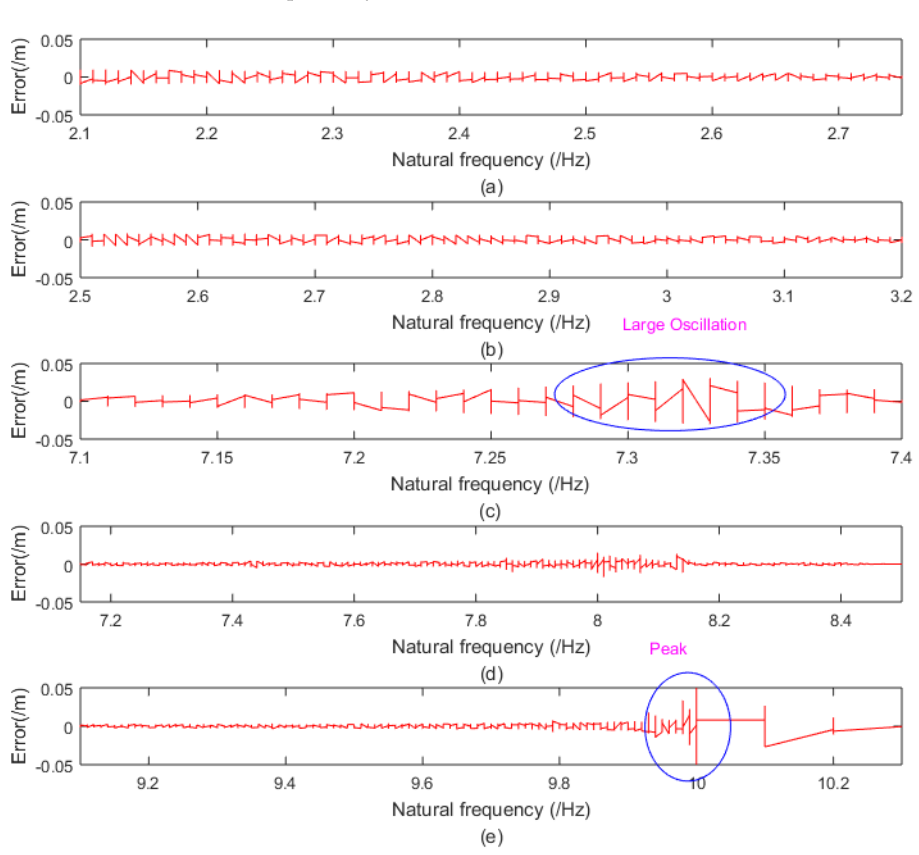
Figure 8. The differences between the Kriging surrogate model prediction and precise results; ( a – e ) are for first five vibration modes, respectively.